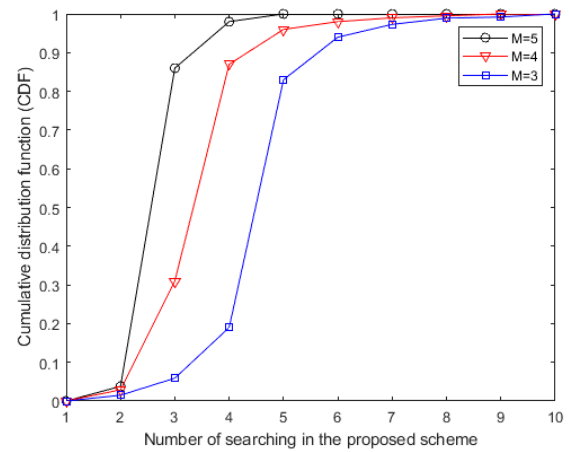
with an iteration interval of ∆ = 0.01.